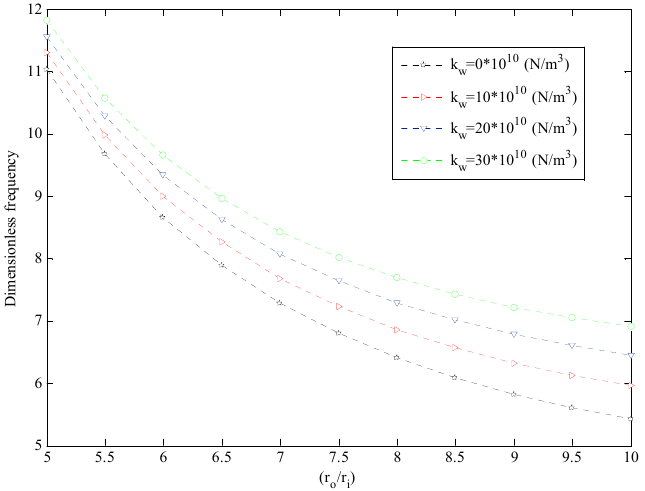
Figure 2. Dimensionless frequency versus radial ratio for different Winkler coefficients.